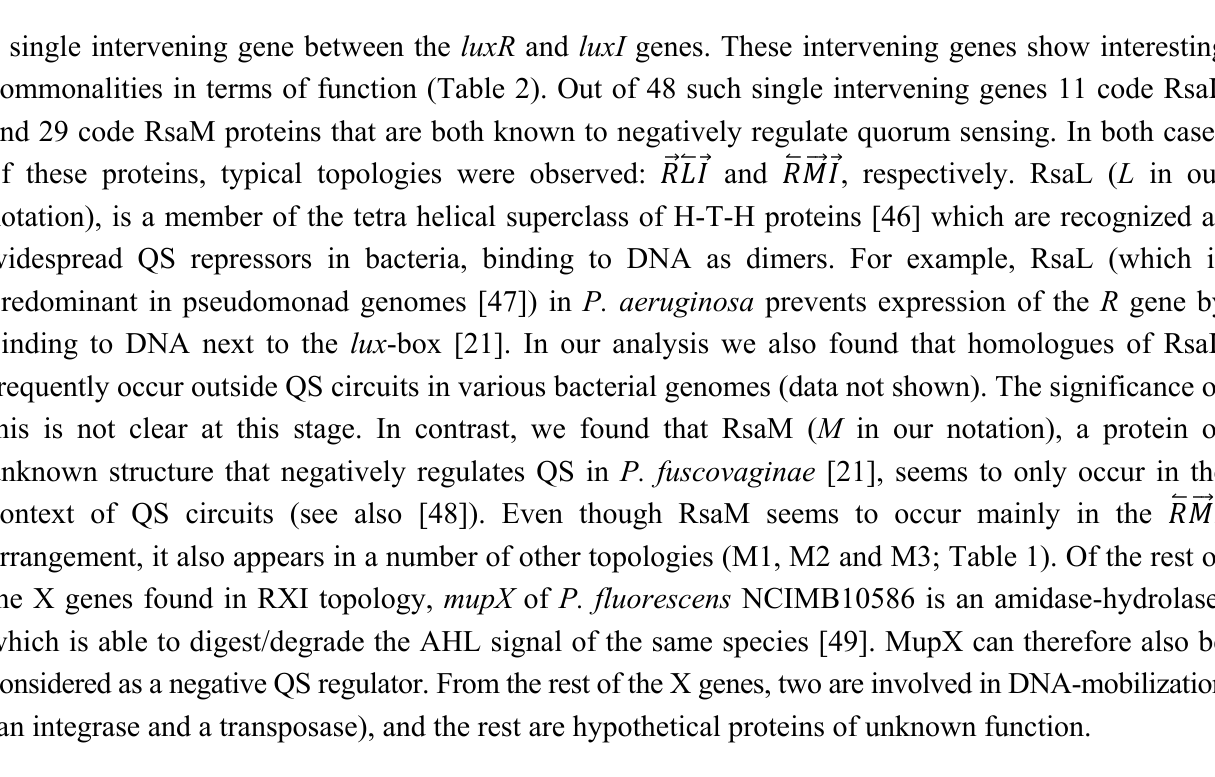
Table 2. Intervening genes in short, conserved topological